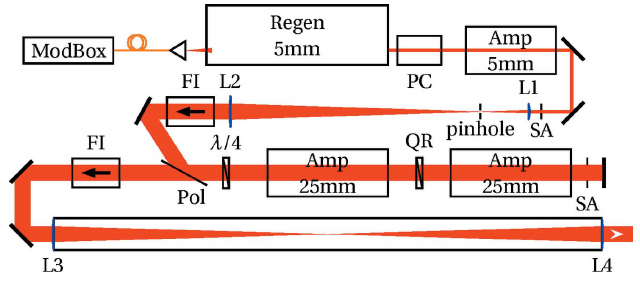
Figure 3 Optical layout of the laser front-end; see text for details. PC is the Pockels cell, Amp are the rod amplifiers with their diameter for indication, SA are the apodizing apertures, L are the lenses, FI are the Faraday Isolators, Pol is the thin-film polarizer and QR is the quartz